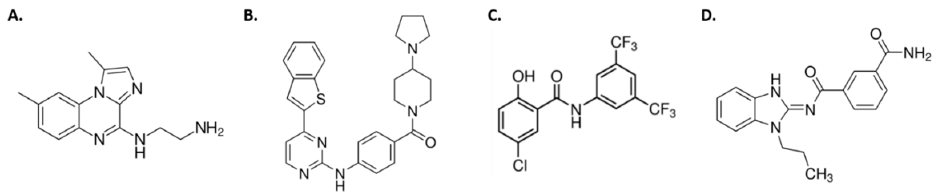
Figure 2. Chemical structures of NF-kB signaling inhibitors. ( A ) BMS345541. ( B ) IKK16. ( C ) IMD0354. ( D ) Takinib.